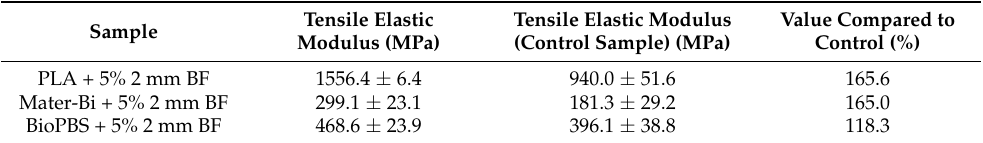
Table 13. Tensile elastic modulus comparison of the 2nd generation with the control sample (with- out fiber).